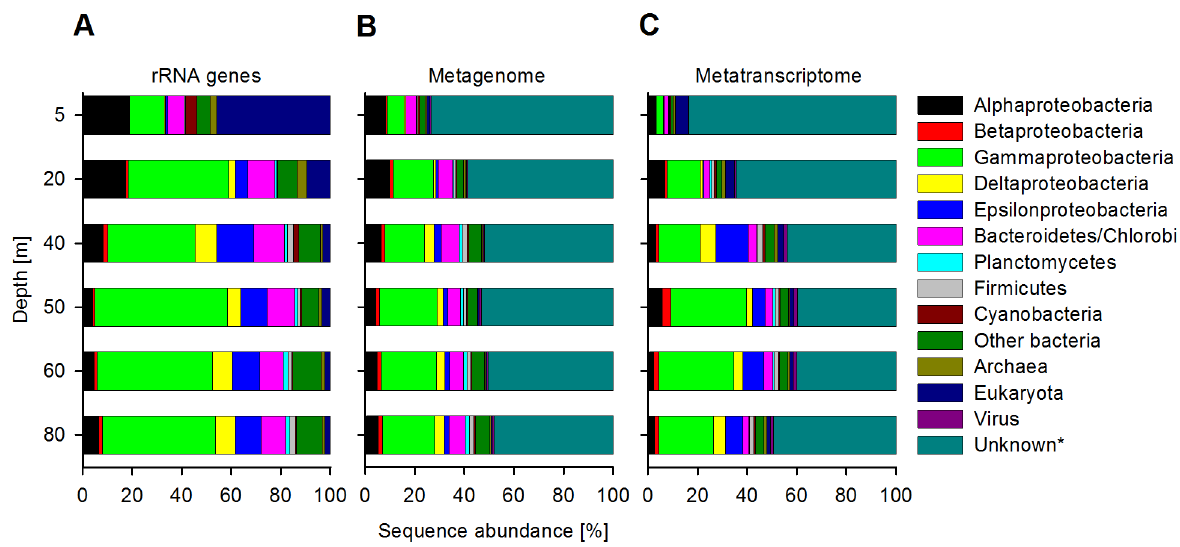
Figure 3. Vertical distribution of taxonomic assignments. Shown on either domain, phylum or class level. (A) rRNA genes in percent of all rRNA genes (5,923 sequences). (B) Metagenomic sequences in percent of all metagenomic sequences (1,882,842 sequences, excluding rRNA genes). (C) Metatranscriptomic sequences in percent of all metatranscriptomic sequences (421,528 sequences, excluding rRNAs). ‘Other Bacteria’ include Acidobacteria, Actinobacteria, Aquificae, Chlamydiae, Chloroflexi, Deferribacteres, Deinococcus-Thermus, Dictyoglomi, Elusimicrobia, Fibrobacteres, Fusobacteria, Gemmatimonadetes, Lentisphaerae, Nitrospirae, Spirochaetes, Synergistetes, Tenericutes, Thermotogae and Verrucomicrobia. *Sequences with no significant match against the non-redundant database of NCBI or sequences with a match that lacks taxonomic